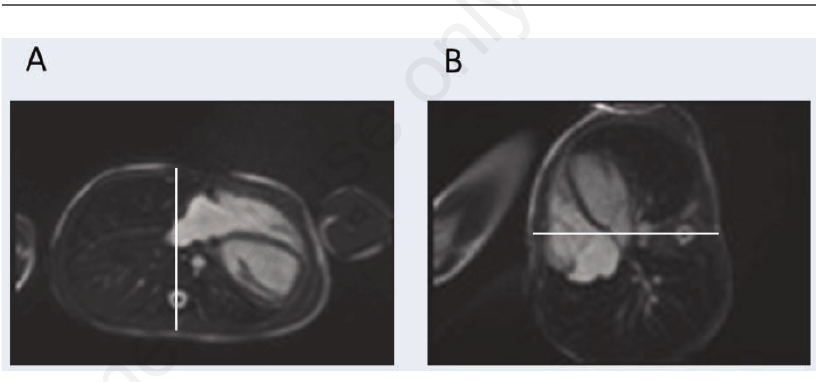
Figure 1. Contrast enhanced thoracic computed tomography in axial view, showing the leftward displacement of the heart and the hypoplasia of the left lower lobe. No pericar- dial lining is visible.